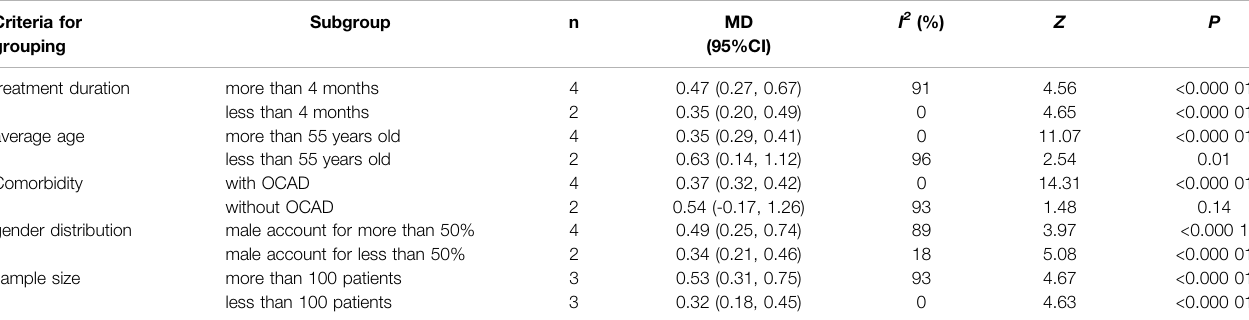
TABLE 2 | Subgroup analysis of CFR based on treatment duration, average age, comorbidity, gender distribution and sample size. Criteria for grouping treatment duration